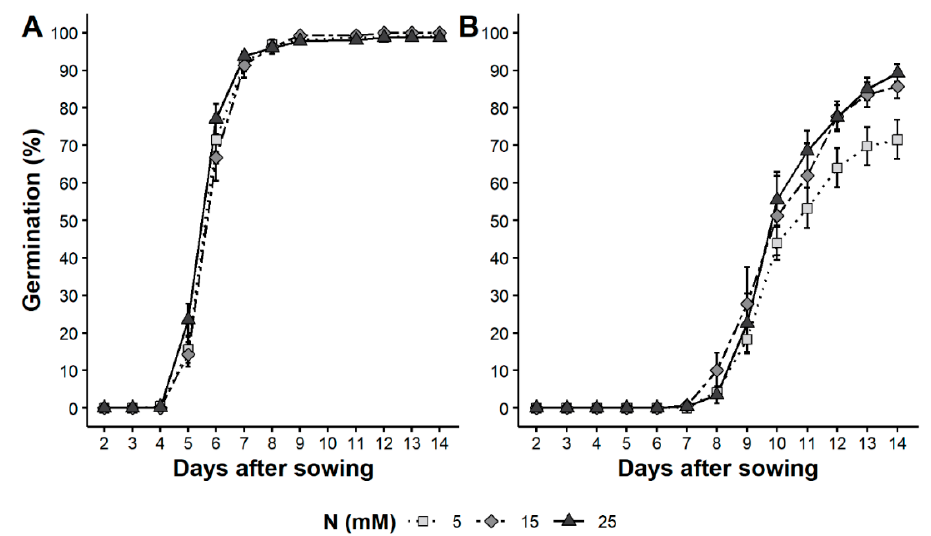
Figure 4. Germination curves at five months since harvest of seeds from tomato plants fertigated with solutions of 5, 15 or 25 mM nitrogen (N) concentration. ( A ) Germination in water ( Ψ = 0 MPa). ( B ) Germination in − 0.10 MPa water potential solution. Data are an average of four replicates, with two sub-samples of 50 seeds each, and bars represent standard error.